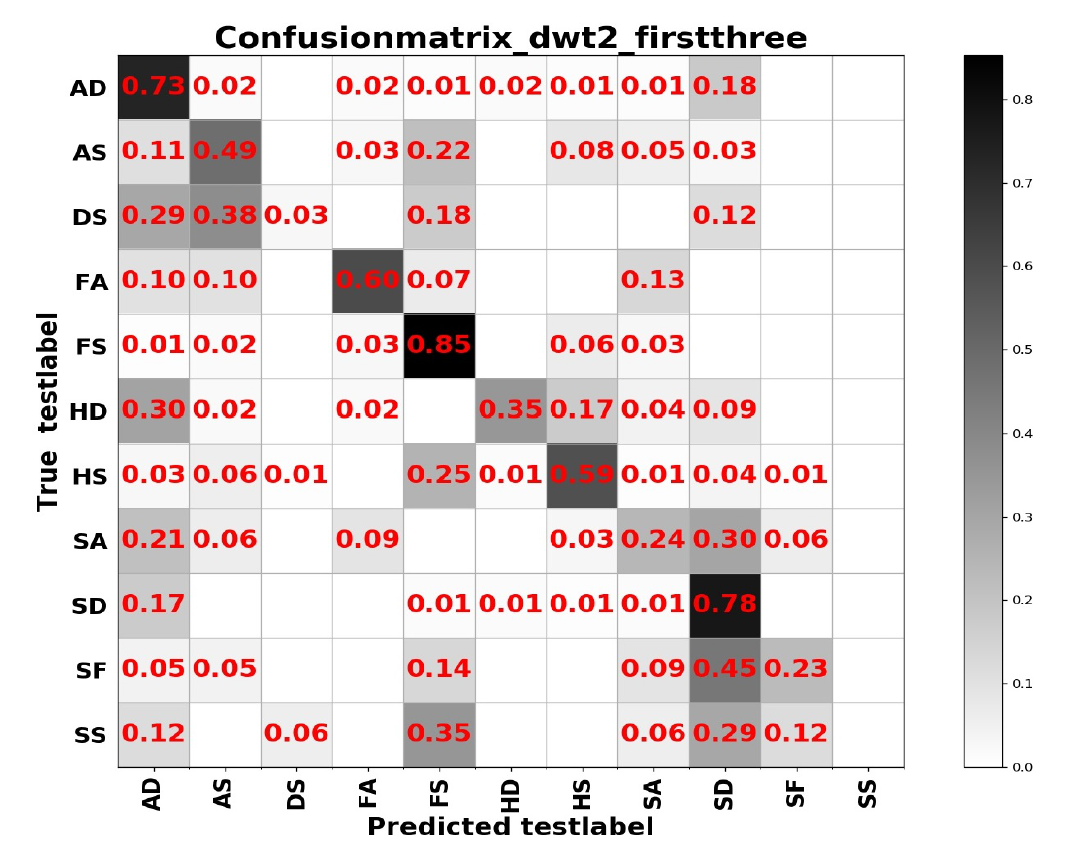
Figure 13. The confusion matrix of the RAF Compound test based on frequency domain images under rbio.3.1.